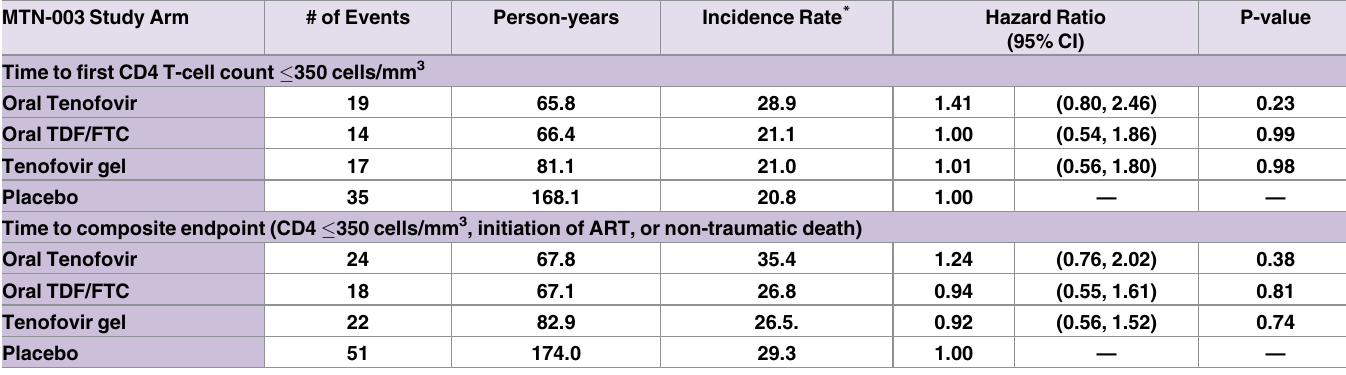
Table 3. Unadjusted Cox proportional hazards model for time to first CD4 (cid:20) 350 and time to composite disease progression